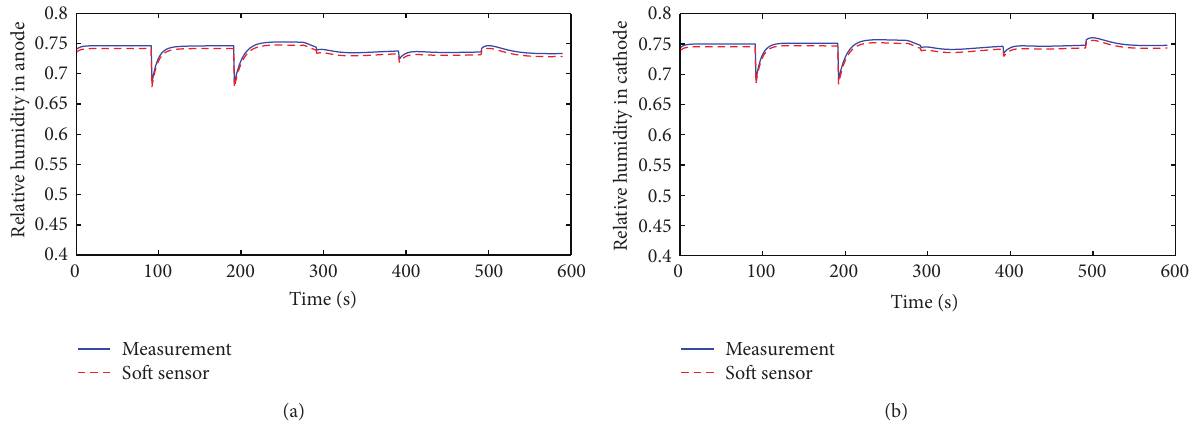
Figure 14: Comparison of measured and soft sensor’s relative humidity with rapid start when relative humidity of cathode is set as 0.75. (a) Anode; (b) cathode.